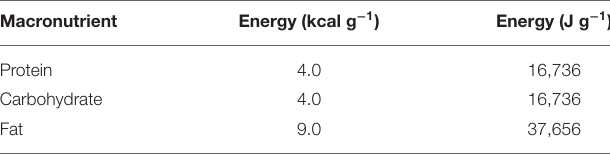
TABLE 1 | Amount of energy from 1g of each macronutrient.